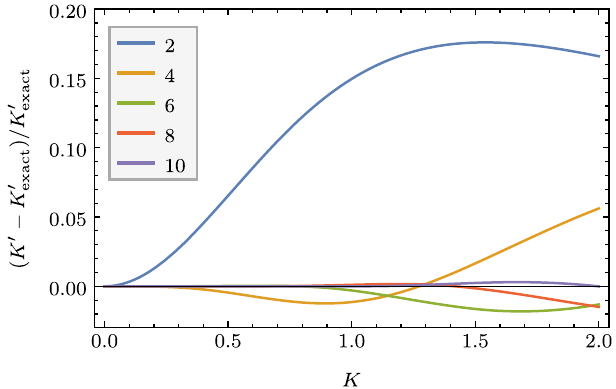
FIG. 3. The relative difference between the renormalized NN coupling obtained from the cumulant expansion of the RSMI- favored solution (decimation) and the nonperturbative result Eq. (15). The convergence improves with increasing order of cumulant expansion M and lower K